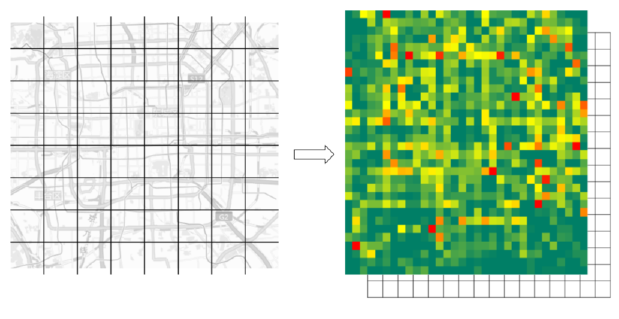
Figure 1. Bus traffic flow